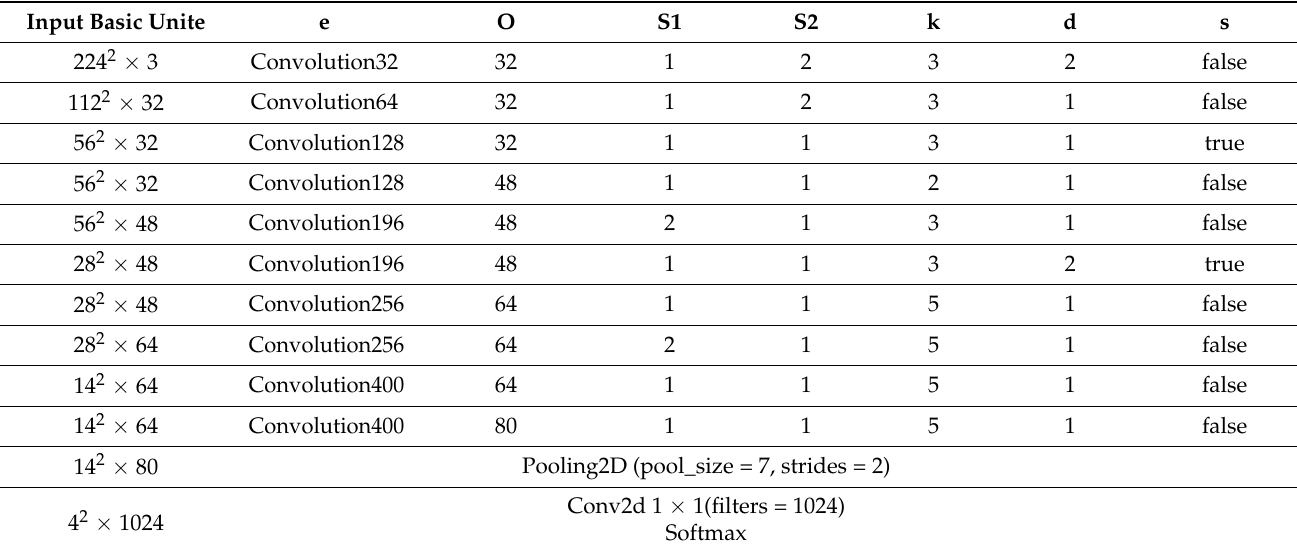
Table 2. Network parameters of the wheat growth stage detection model.